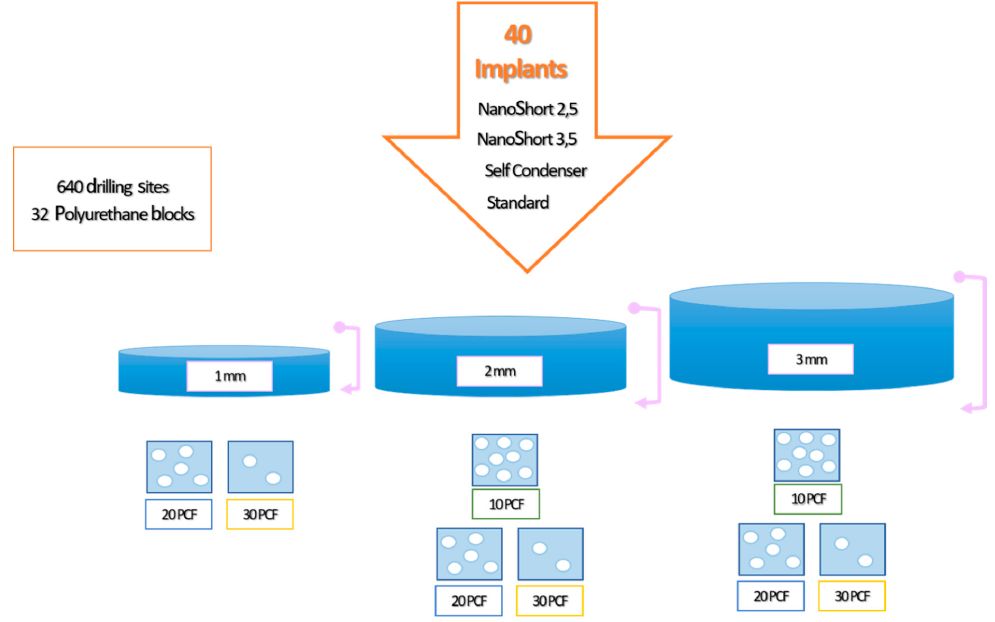
Figure 1. Summary of the model design of the study.